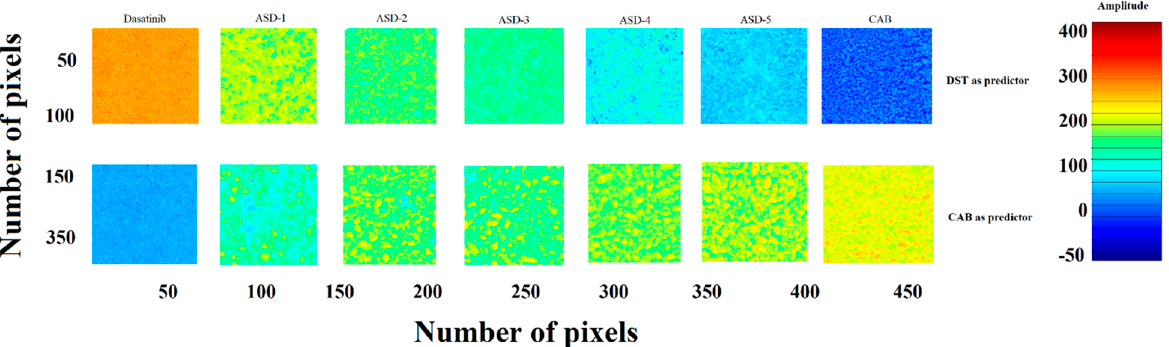
Figure 6. PLS concentration images of